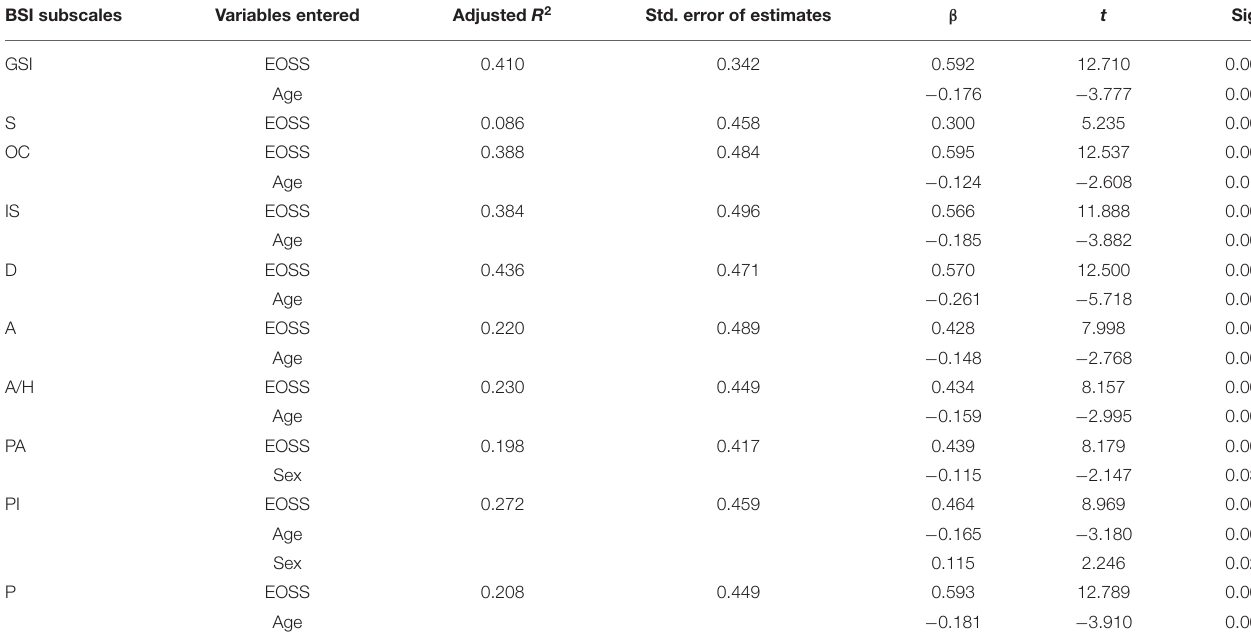
TABLE 3 | Linear regression analysis for the BSI scales. BSI